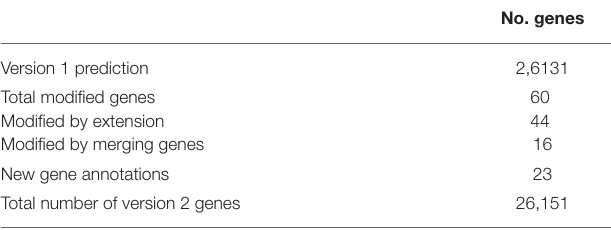
TABLE 5 | Summary of original predicted and newly annotated/ edited genes using proteogenomics.